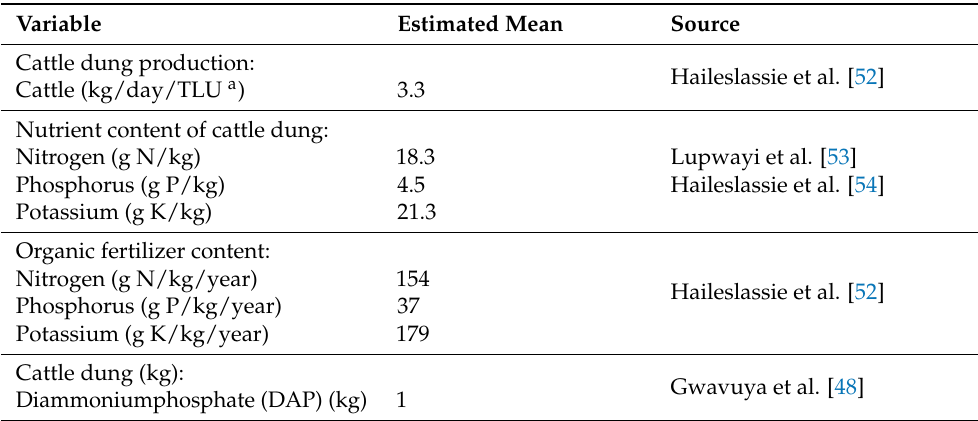
Table 2. Sub-model parameter values for cattle dung and fertilizer. Variable Estimated Mean